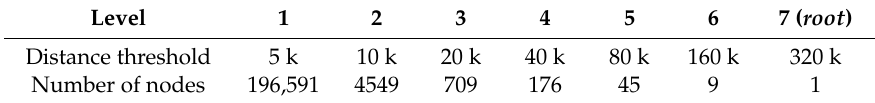
Table 2. Distance thresholds and the resulted number of nodes for each level of the Aerosol dataset.